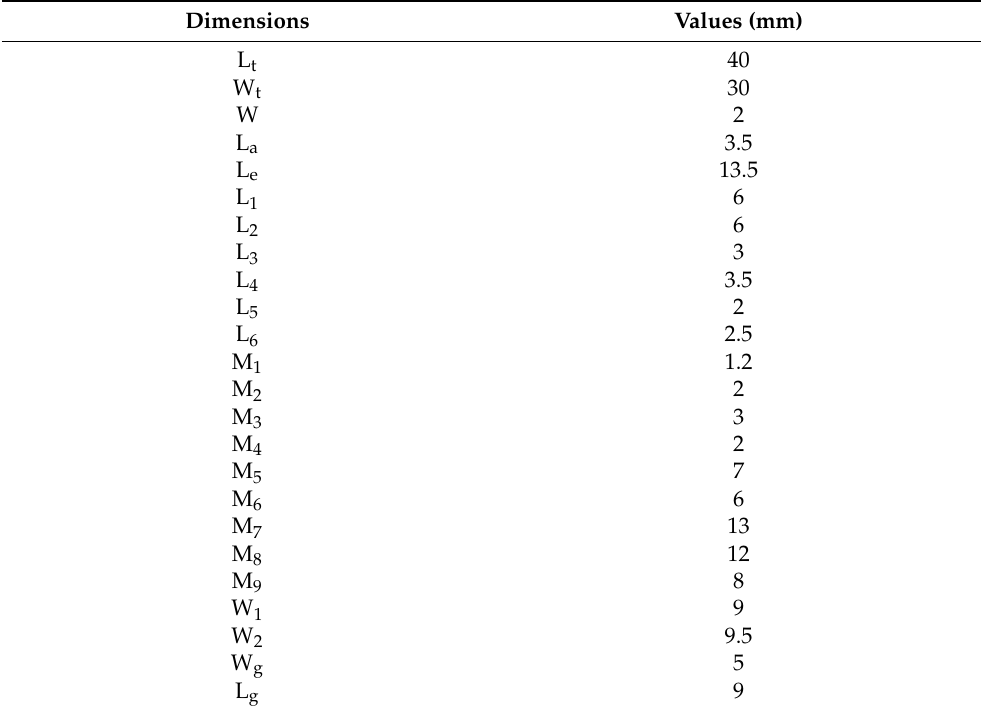
Figure 5. Proposed antenna structure, ( a ) Top side, ( b ) Bottom side. Table 3. All antenna dimensions.